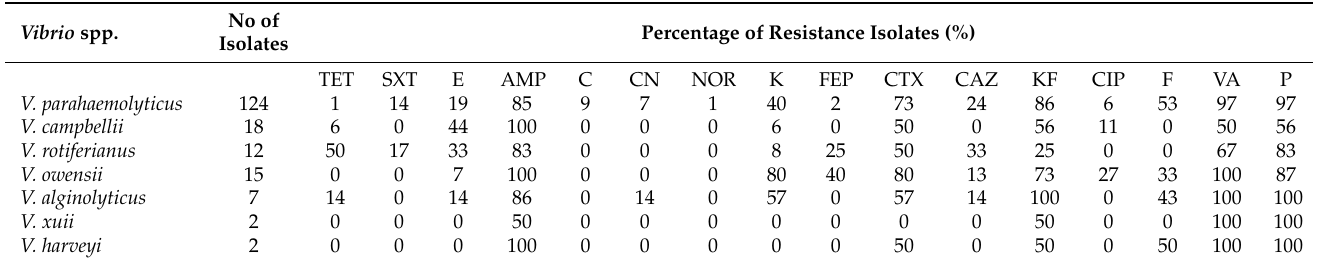
Figure 3. Neighbor-joining phylogeny (Kimura 2-parameter model) of concatenated partial pyrH gene sequences from Vibrio spp. isolated from cultured shrimp. Bootstrap values represent 1000 replications. Reference sequences were acquired from the NCBI GenBank. Table 4. The percentage of antibiotic resistance profiles of Vibrio spp. collected from seven shrimp farms in different geographical regions of Peninsular